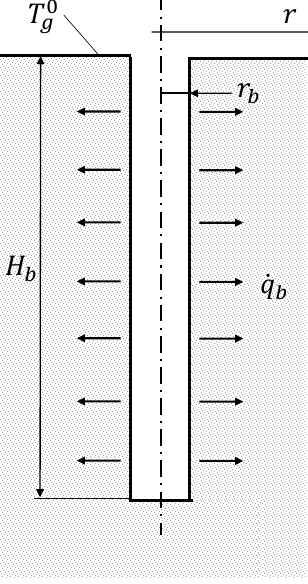
Figure 8. Schematic representation of the “hollow” finite cylindrical source